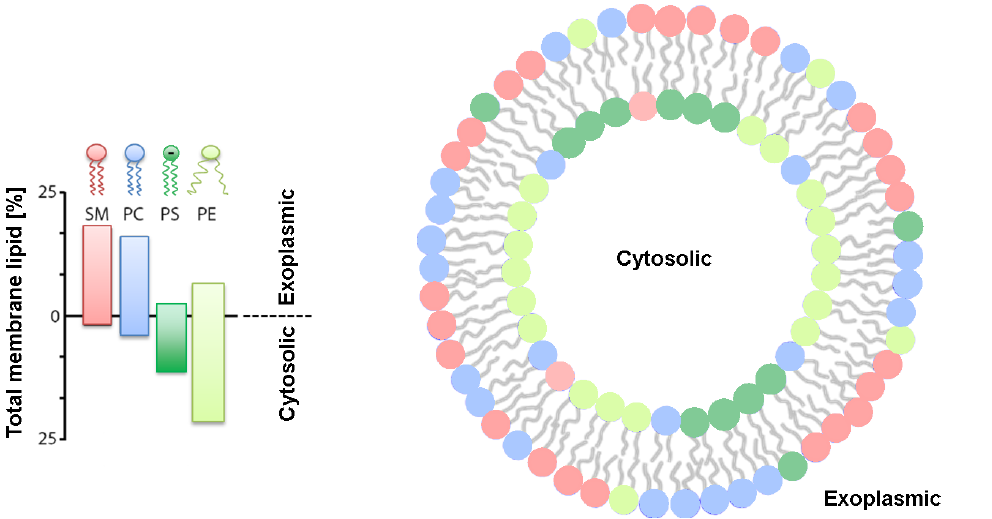
Figure 1. Proposed distribution of phospholipids in human red blood cells put forward by Verkleij et al.